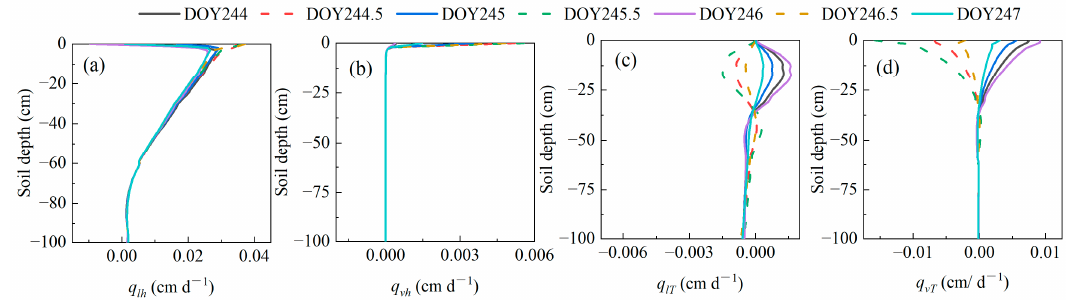
Figure 5. Simulated vertical distributions of the thermal and isothermal fluxes of liquid water and vapor during a typical dry period from DOY 244 to 247 (1–4 September 2013) for BT: ( a ) the isothermal liquid water flux ( q lh ); ( b ) the isothermal vapor flux ( q vh ); ( c ) the thermal liquid water flux ( q lT ); ( d ) the thermal vapor flux( q vT ). All fluxes are positive upward. Table 5. The proportion of each soil water flux component to total flux during a 3-day period before and after irrigation for SMT and a dry period for